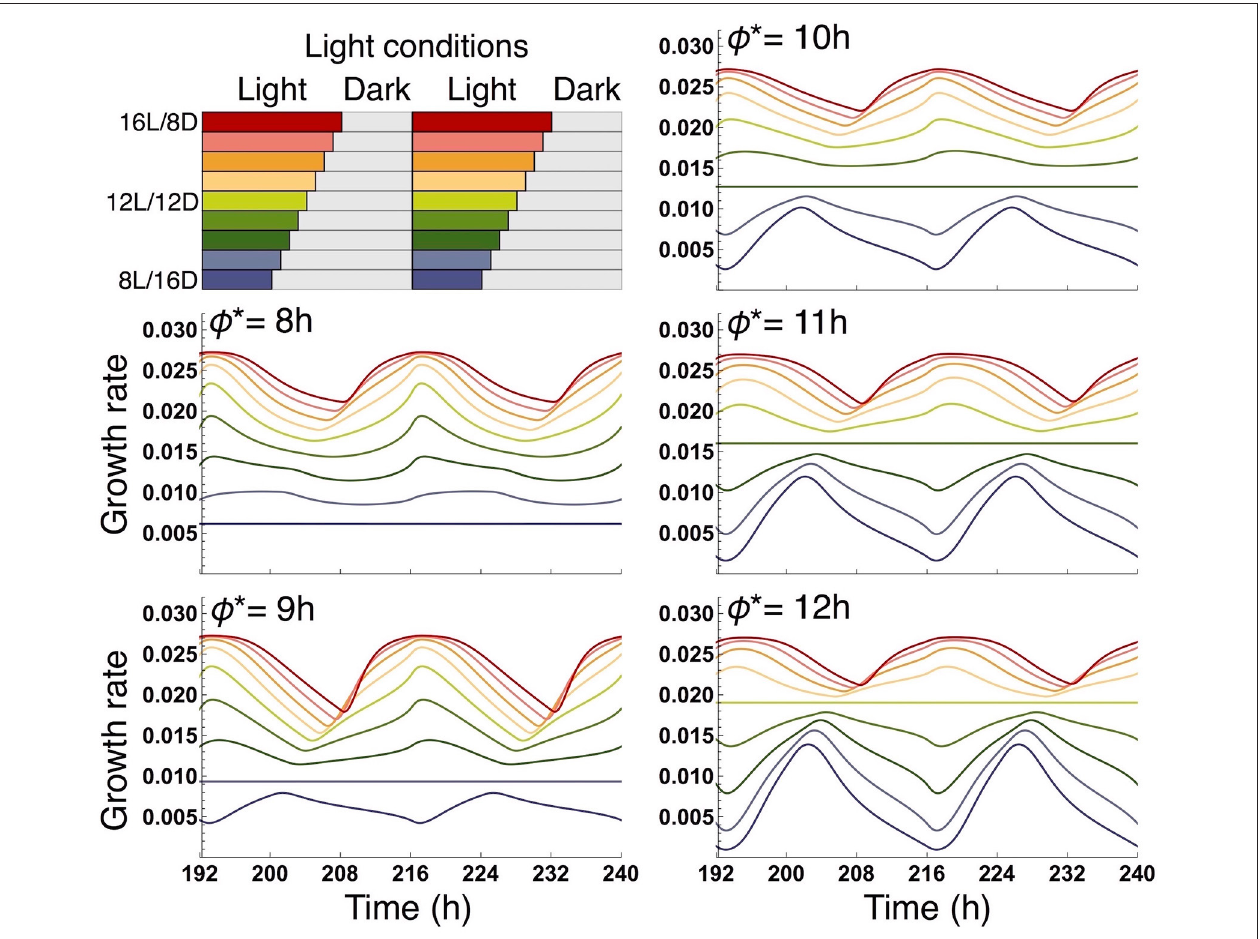
FIGURE 7 | Comparison of growth rate of the sink (SAM or RAM) of the wild type at various values of the subjective dusk φ *. In each panel, growth dynamics in various photoperiods is represented. Different colors correspond to different light conditions (upper left